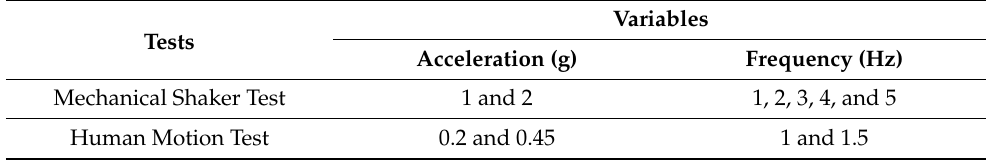
Table 7. Variables engaged in shaker and human motion tests. Tests